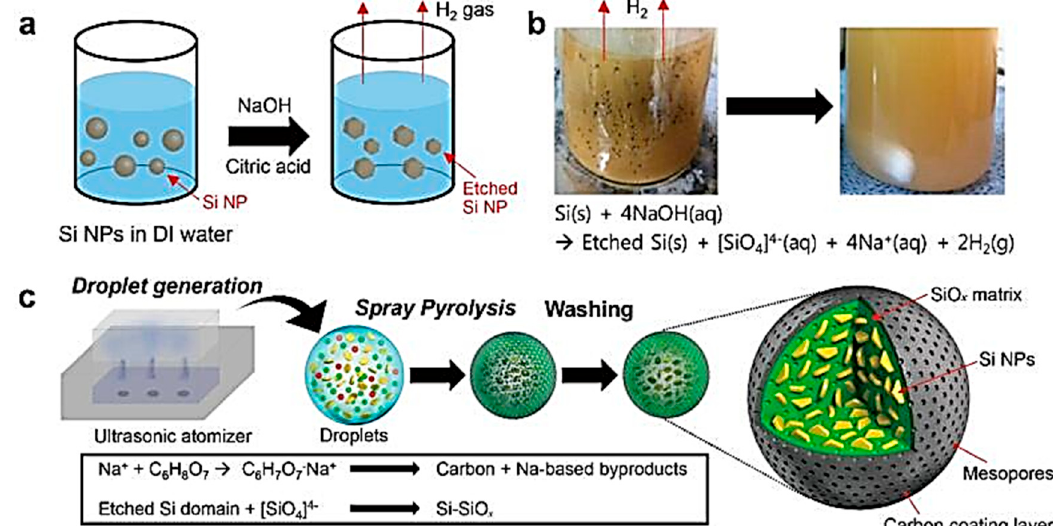
Figure 3. The synthesis illustration of the Si-SiOx@C compound material. ( a ) Schematic illustration of the preparation of the precursor solution. ( b ) Photographs of the precursor solution before and after the denoted reaction. ( c ) Graphical presentation for the synthesis of the Si − SiOx − C composite from the spray pyrolysis through a final washing step. Reprinted (adapted) with permission from [35], copyright 2017 American Chemical Society.